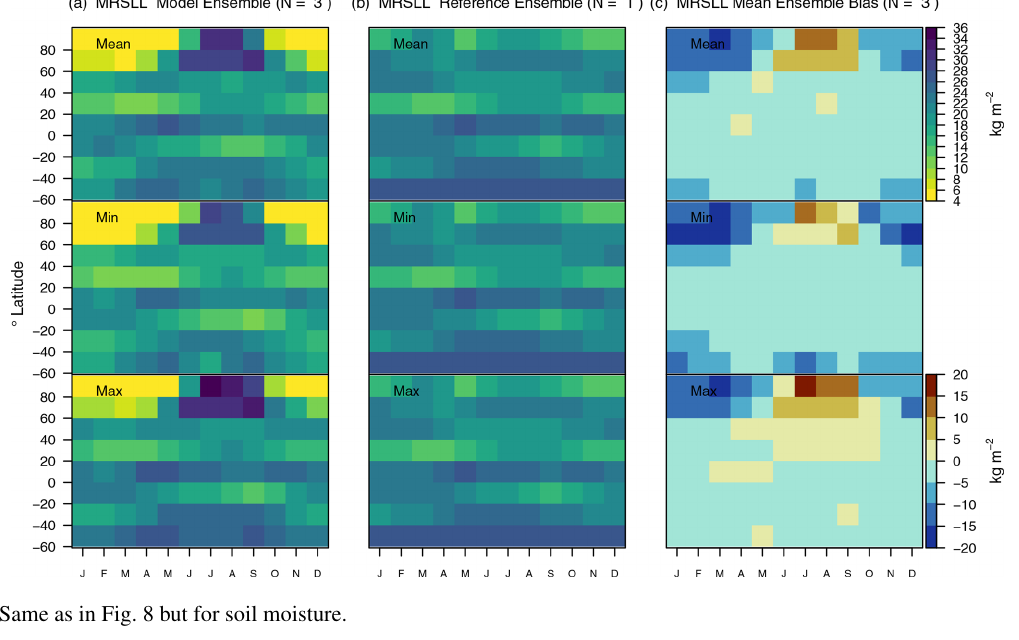
Figure A12. Same as in Fig. 8 but for soil moisture.